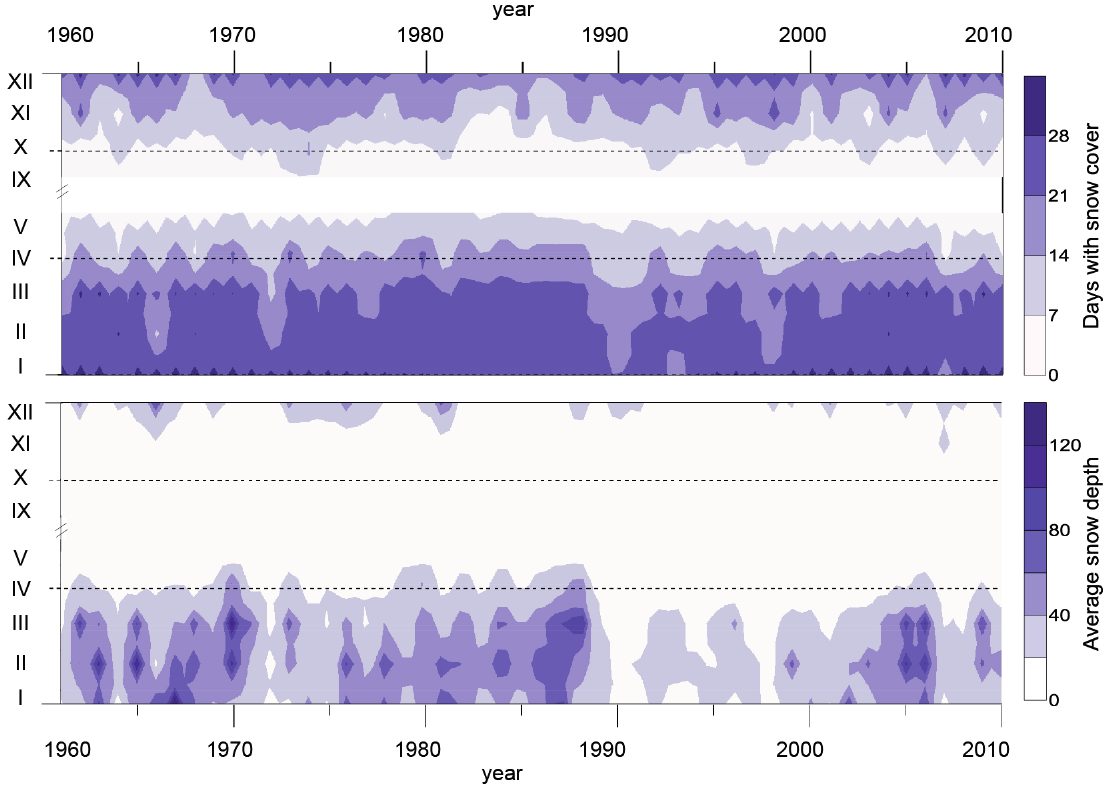
Figure 4. Interpolated values of number of days with snow cover and average snow depth by years and months at the Churá ň ov monitoring station during